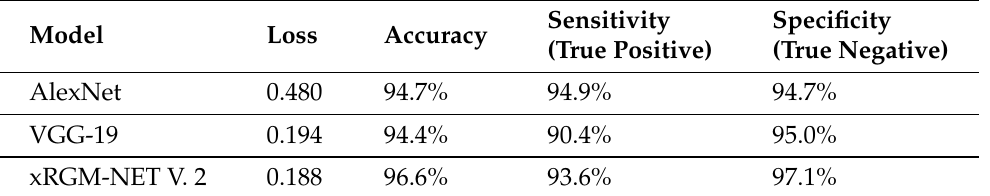
Table 2. xRGM-NET vs. other models with geometric